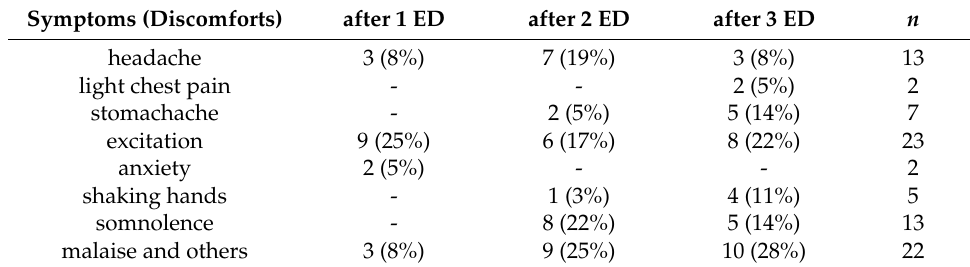
* Each participant could report more than 1 discomfort after consuming ED.